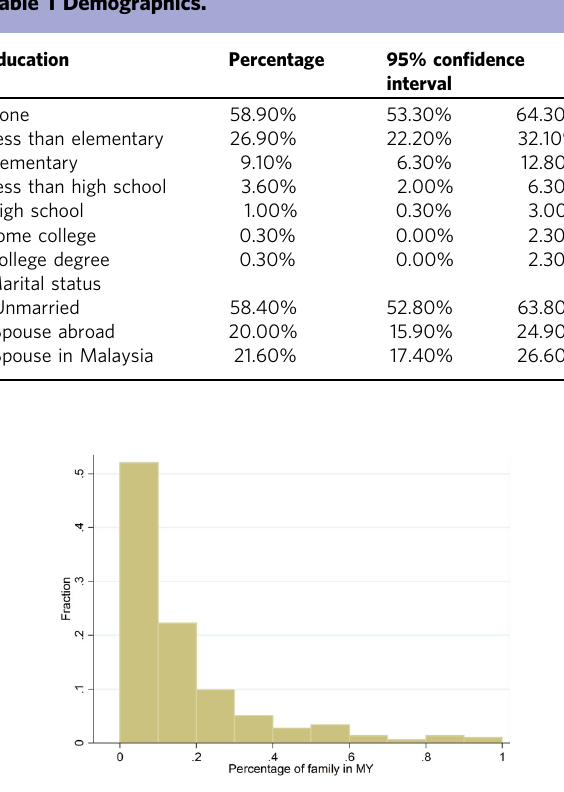
Fig. 3 Distribution of percentage of family in Malaysia. Respondents distribution by percentage of family in Malaysia, de fi ned as the number of living parents, siblings, children, and spouses in Malaysia divided by the number of livin parents, siblings, children, and spouses.